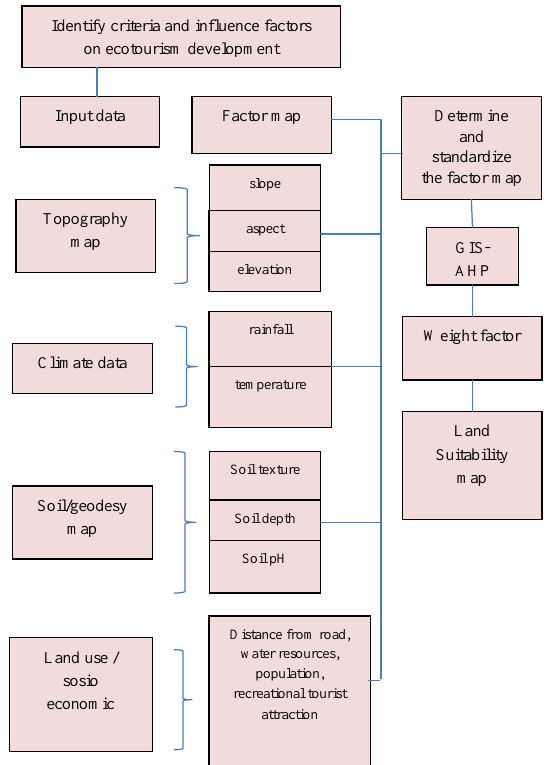
Figure 2 : The framework of land